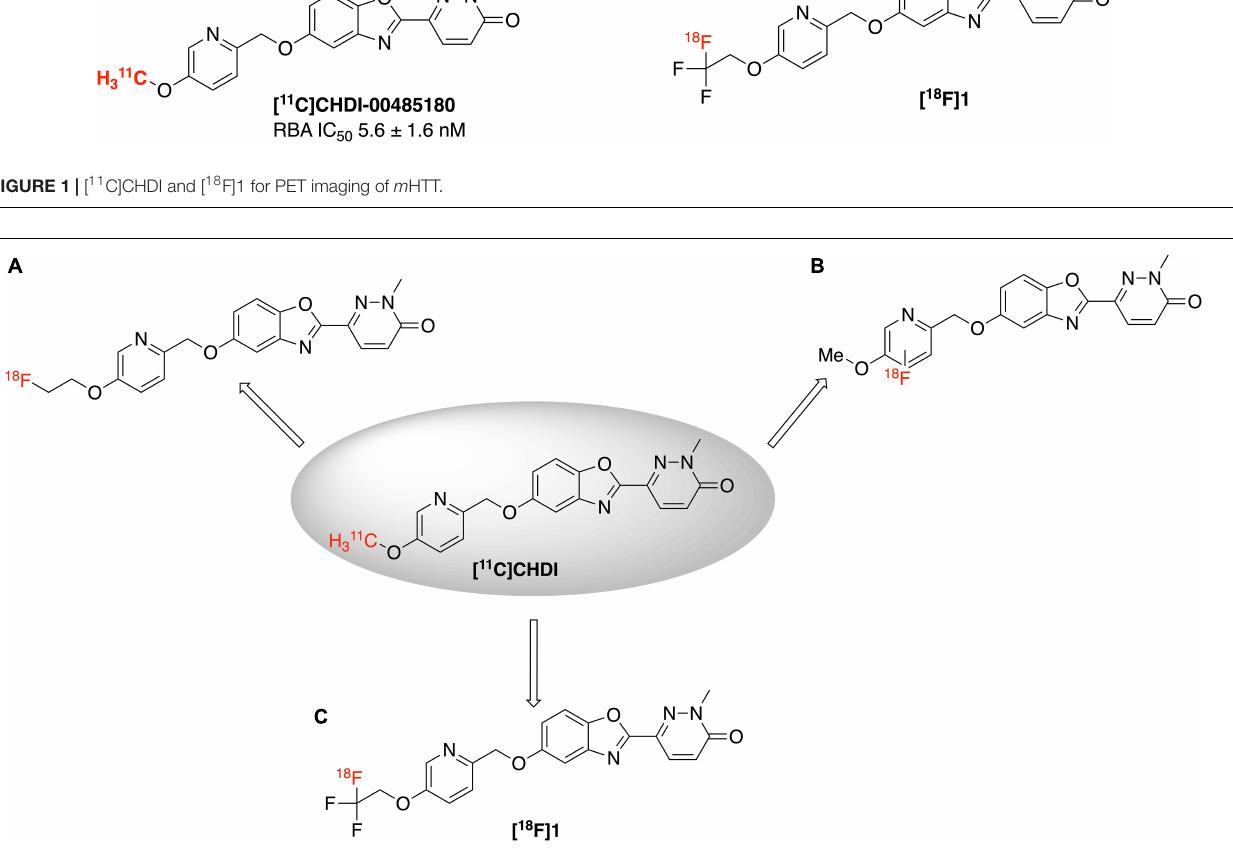
FIGURE 2 | Proposed 18 F analogs of [ 11 C]CHDI for PET imaging of m